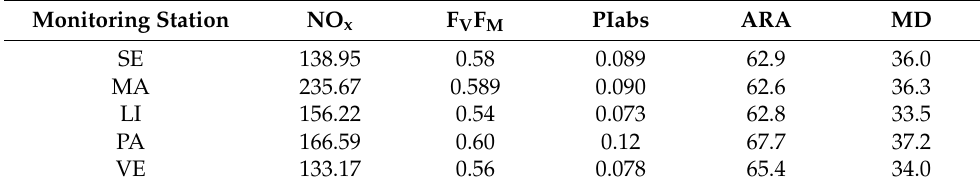
Figure 8. Location of the monitoring stations that measured the NO x during the exposure period. Table 3. Hourly mean concentrations ( µ g m − 3 ) of NO x are reported for each monitoring station. Physiological parameters values in a 100 mt area surrounding the station are also reported.